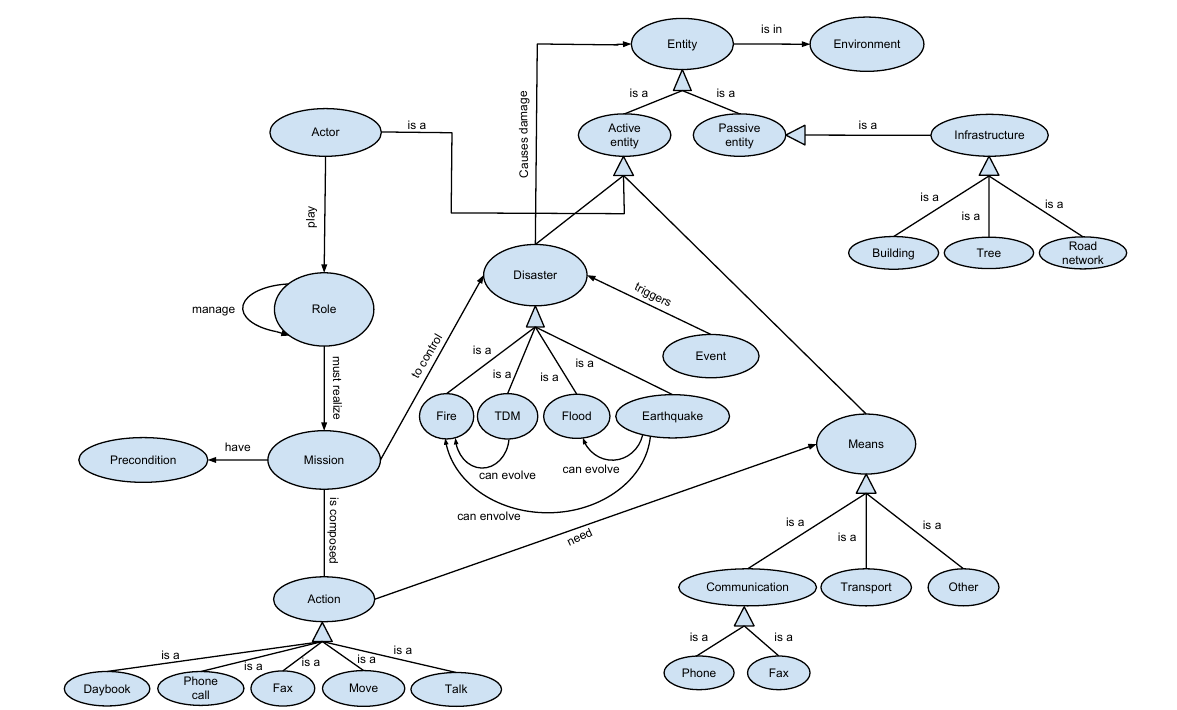
Figure 3. An ontology describing the general domain of